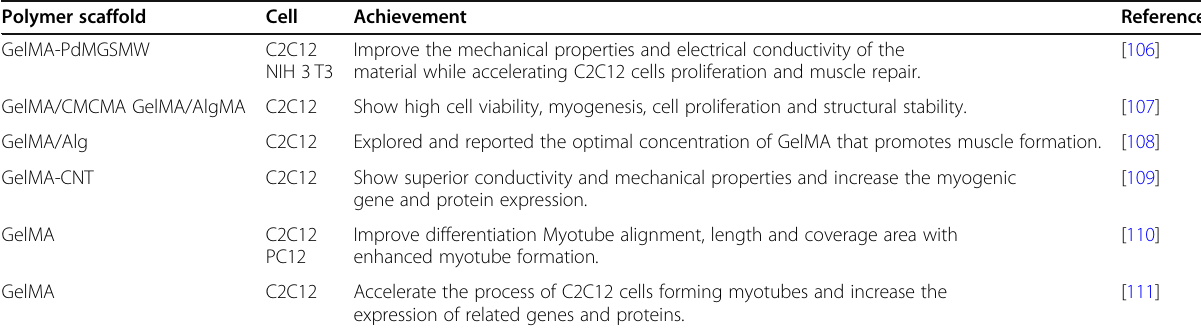
Table 5 The recent application of GelMA in skeletal muscle engineering Polymer scaffold